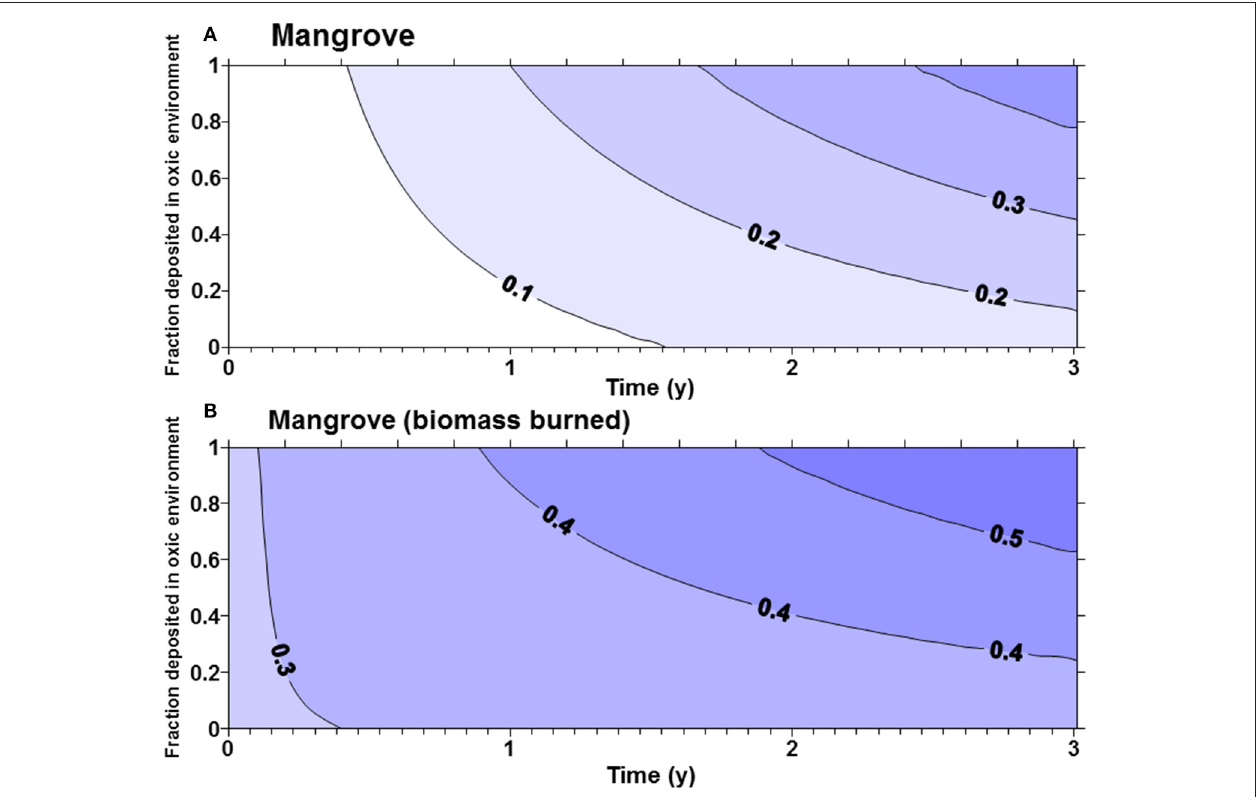
FIGURE 2 | (A) Fraction of the original organic carbon contained in the biomass and top meter of sediment in a mangrove forest emitted as a function of time and α , the fraction deposited in oxic environments. More than 40% of the original organic matter will be mineralized in 3 years if all of the organic matter is deposited in oxic environments. (B) The fraction of the original organic carbon emitted if all aboveground biomass is burned upon land clearing of